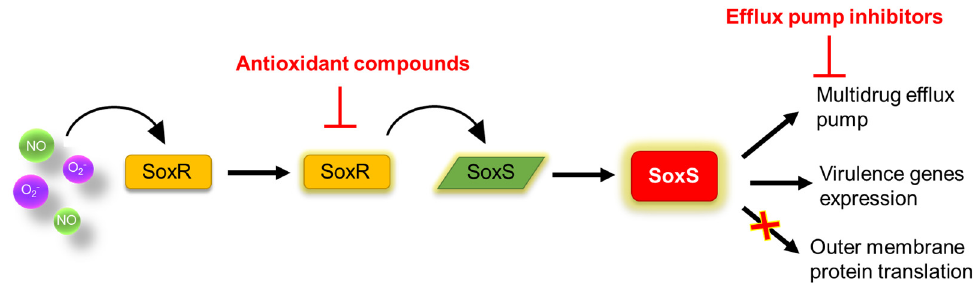
Figure 8. Bacterial oxidative stress response.